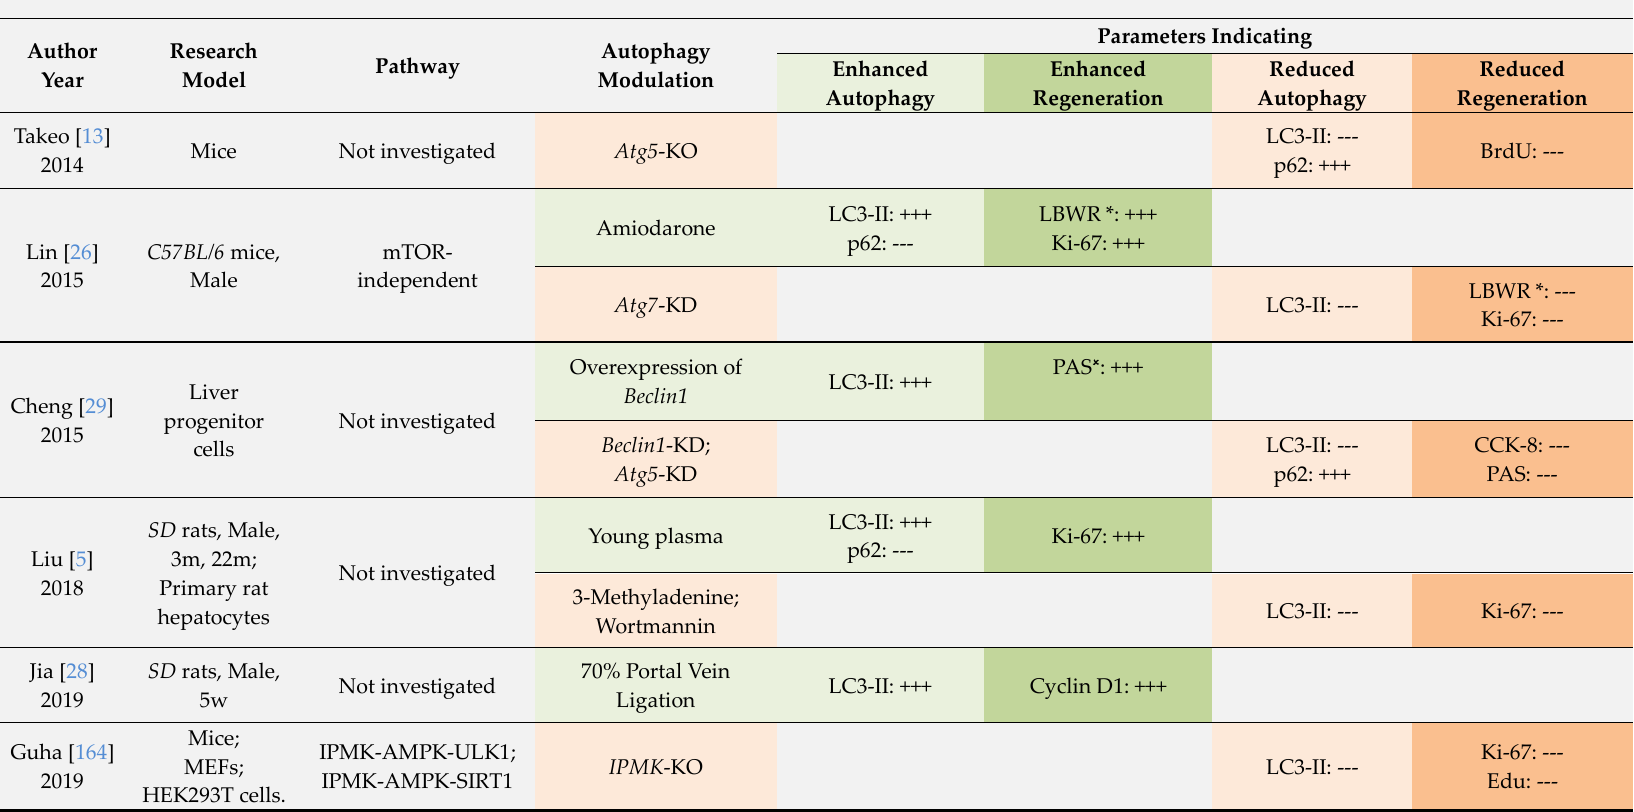
Table 3. Controversy about role of autophagy in influencing regeneration.